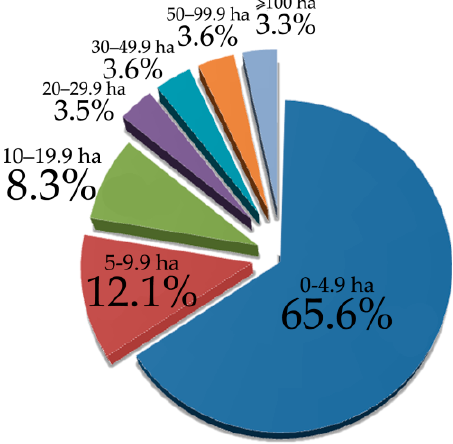
Figure 4. Farm size distribution in the EU (2016).